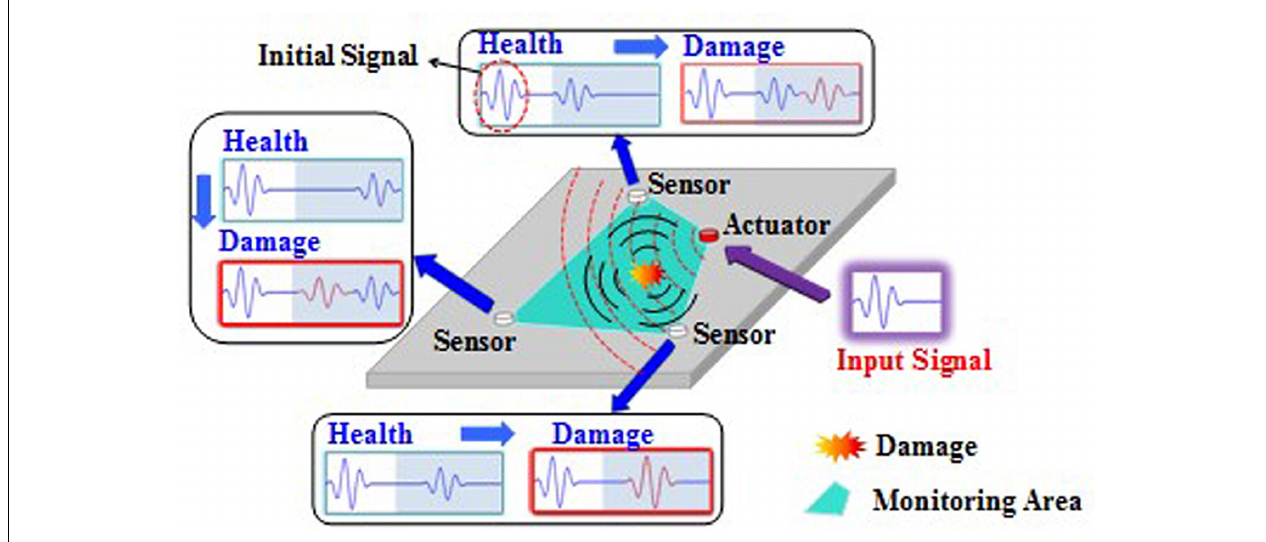
FIGURE 2 | The monitoring principle of the Guided wave method (Wu et al., 2015; Liu et al., 2016a).